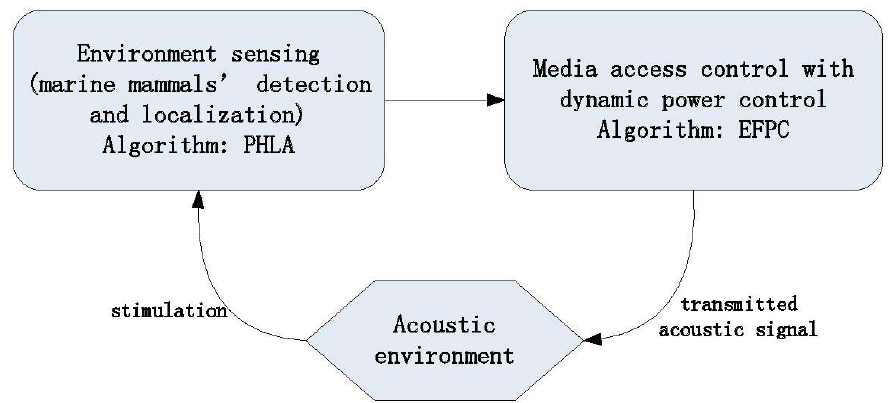
Figure 2. Power control